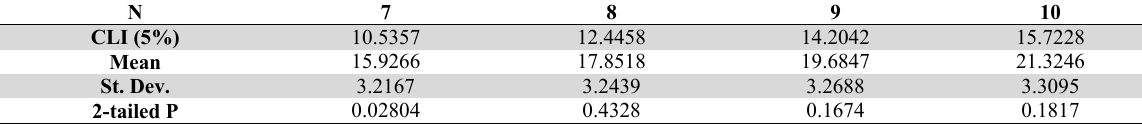
Descriptive statistics and K-S test for 2-diagonal samples